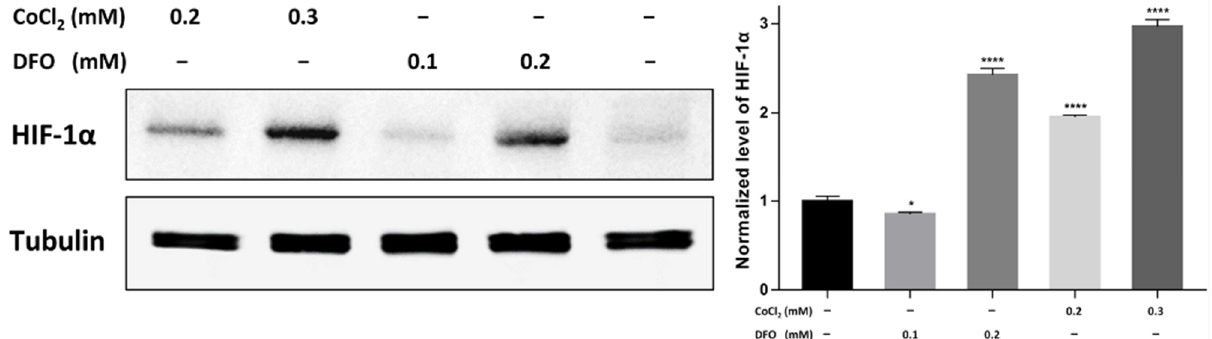
Figure 4. Determination of the condition to stabilize endogenous HIF-1 α protein in HeLa cells via Western blot. HeLa cells were stimulated with the condition indicated on the figure or left untreated. Then, cells were collected and lysed by freeze-thaw cycles. The released cytoplasm was separated by SDS-PAGE and transferred to a nitrocellulose membrane for Western blot analysis. Mouse anti-HIF-1 α IgG and anti-tubulin IgG were incubated with the membranes and HRP conjugated anti-mouse IgG was used to confirm the presence of the bands. The statistical difference in the figures is indicated as follows: * ( p < 0.05), **** ( p <